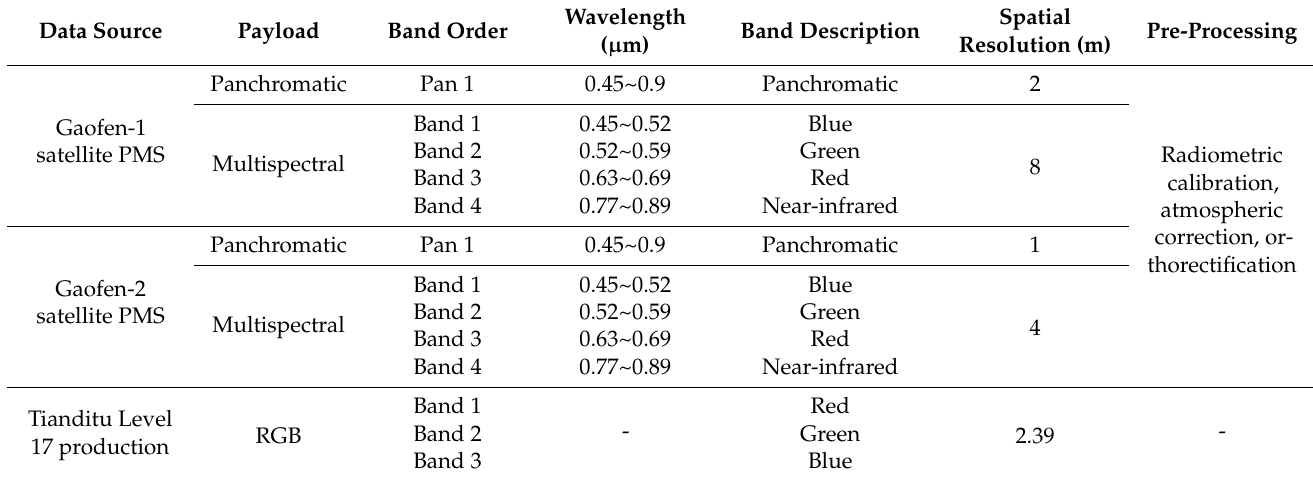
Table 1. Image parameters of the KOMMA